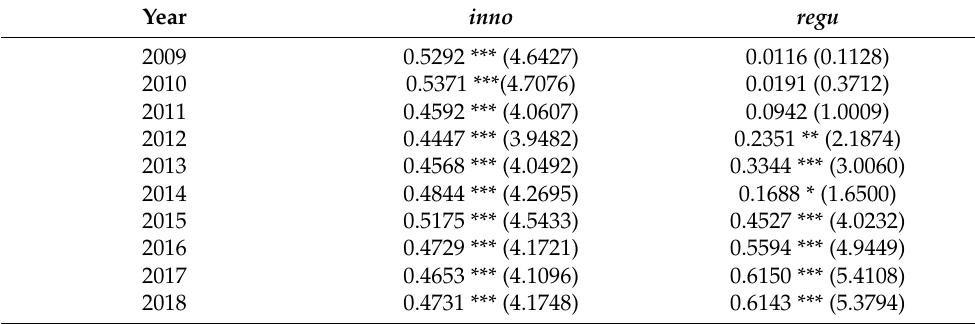
Table 1. Global Moran’s I index of main